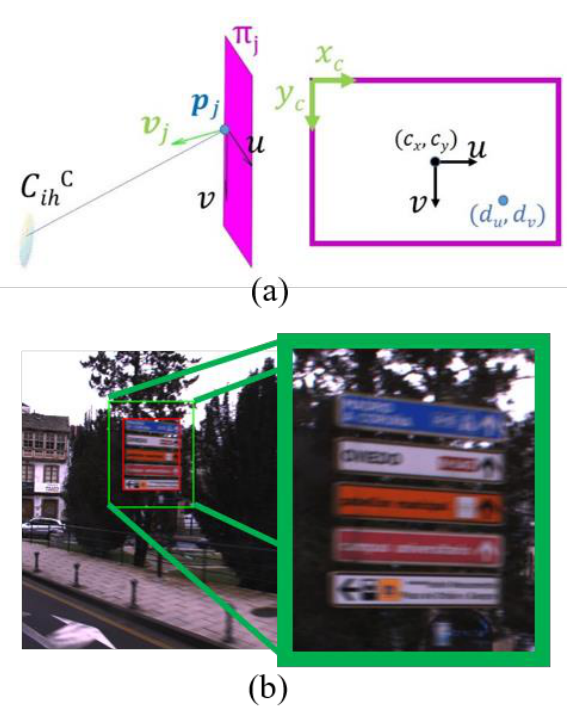
Figure 4. Point cloud projection on images. (a) The points of a traffic sign panel are projected into the camera plane. The distances of the projected point with respect to the principal point of the camera are transformed to pixel coordinates. (b) The bounding box of the projected points (red rectangle) is extended (green rectangle) in order to add some background to the detection, and the image is